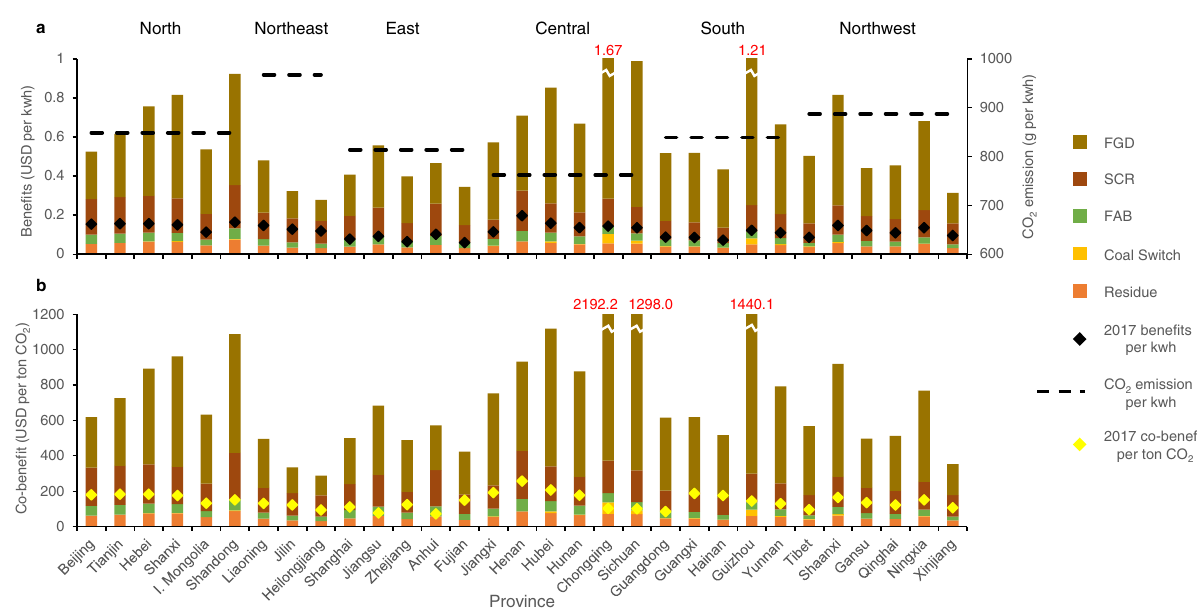
Fig. 4 Potential bene fi ts of emission reduction technologies and the impacts on co-bene fi t values. a Potential bene fi ts of four emission reduction methods in reducing health costs per kWh electricity generation. b Impacts of four emission reduction methods on co-bene fi t values per ton CO 2 emission. The four representative methods to reduce emissions are (1) fl ue gas desulfurization (FGD); (2) selective catalytic reduction (SCR); (3) switching from electrostatic precipitators to fabric fi lters (FAB); and (4) switching from high-sulfur coal to coal with the national average sulfur content. “ Residue ” represents the value under the ideal situation when all methods are perfectly adopted. The black and yellow diamond-shaped dots represent the actual provincial values in 2017.